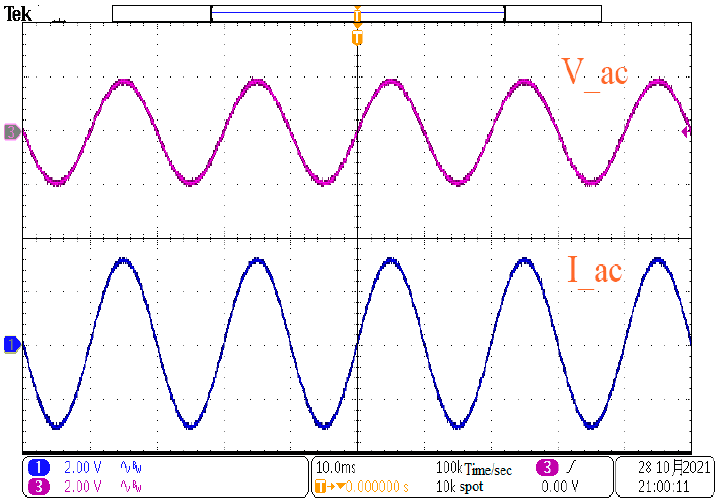
Figure 25. AC loads output under constant load and radiation changes; ( 月 is month).